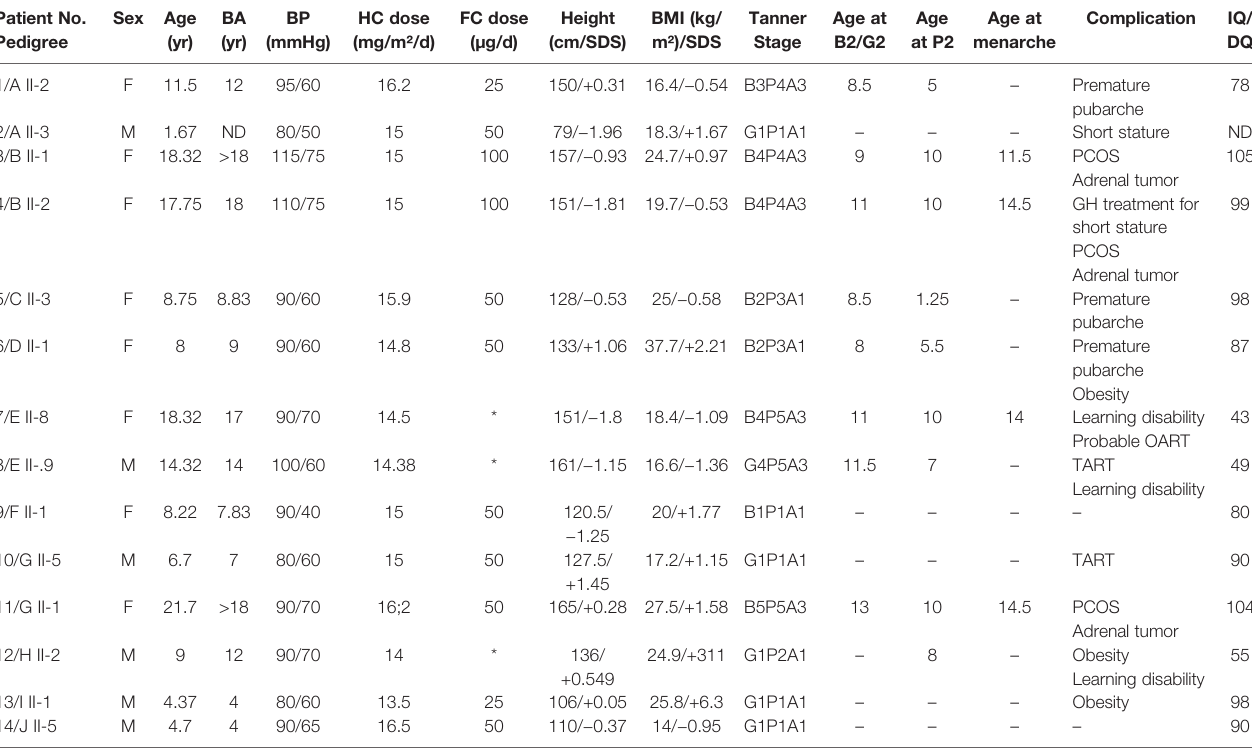
TABLE 3 | Status at most recent follow-up in 14 Algerian patients with genetically con fi rmed 3 b -hydroxysteroid dehydrogenase. Patient No.